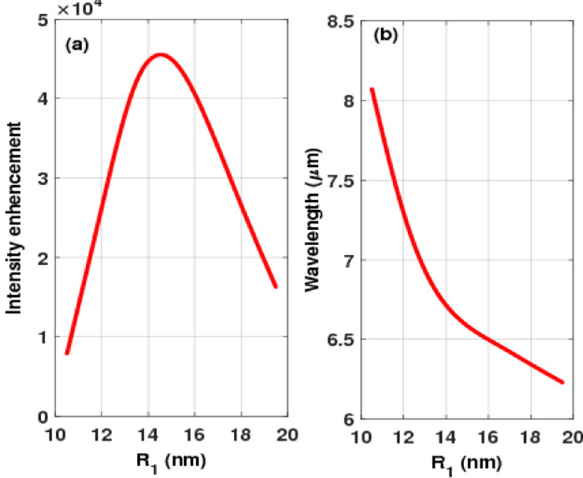
Figure 10. Variation of the local field enhancement centered on the gap with nanorod radius and ( b ) variation of the resonance wavelength with nanorod